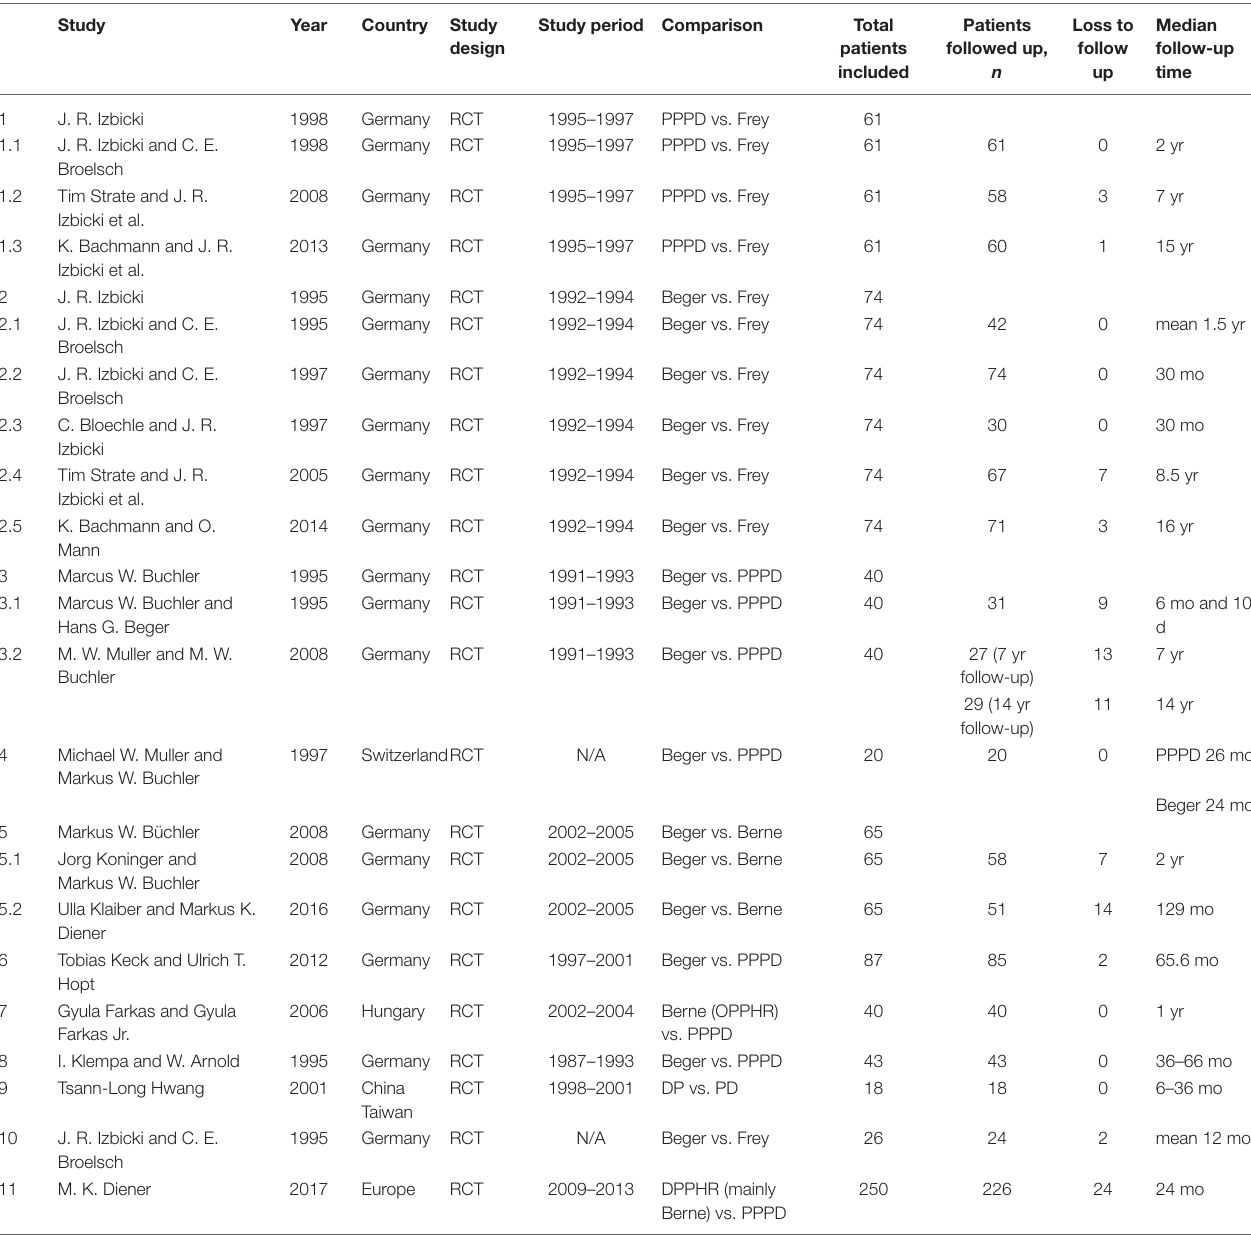
TABLE 1 | Characteristics of included studies. Study Study period Comparison Total